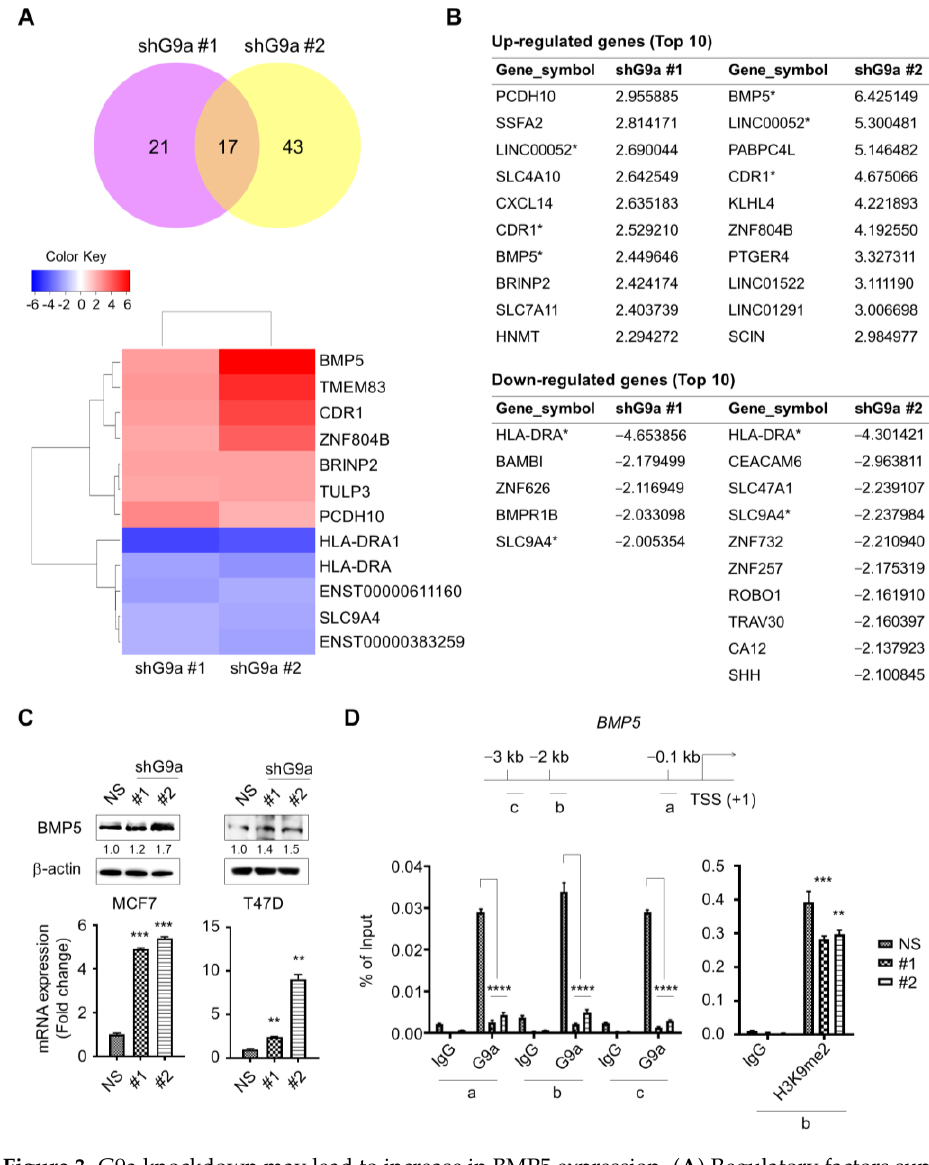
Figure 3. G9a knockdown may lead to increase in BMP5 expression. ( A ) Regulatory factors suppressing tumor aggressiveness were identified by using microarray analysis. ( B ) Expression levels for each gene were compared (ratios between gene expression levels of non-silencing control). In two G9a knockdown cells (shG9a #1 and shG9a #2), expression levels for each gene were compared to those of non-silencing control. Then the most upregulated and downregulated genes were screened. ( C ) G9a knockdown cells showed increase in BMP5 expression. ( D ) Reduced G9a occupancy was found at the BMP5 promoter region. G9a knockdown cells also showed decreased H3K9me2 occupancy at the promoter region of BMP5. p values were calculated using ANOVA. * p < 0.05, ** p < 0.01, *** p < 0.001, **** p <